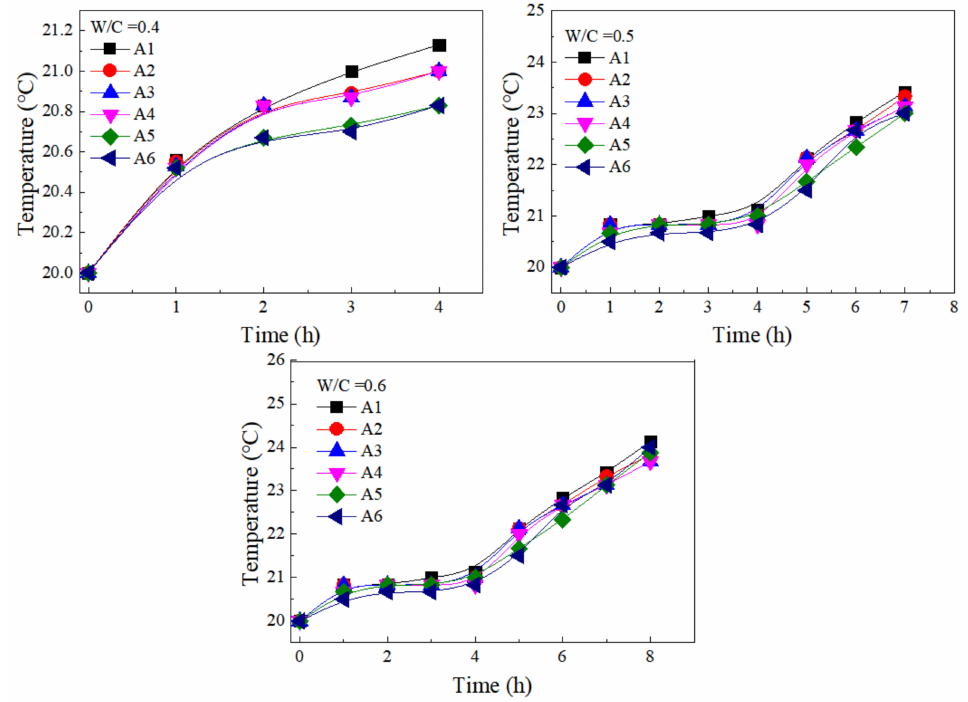
Figure 17. Heat of hydration of cement paste containing SF under different w/c